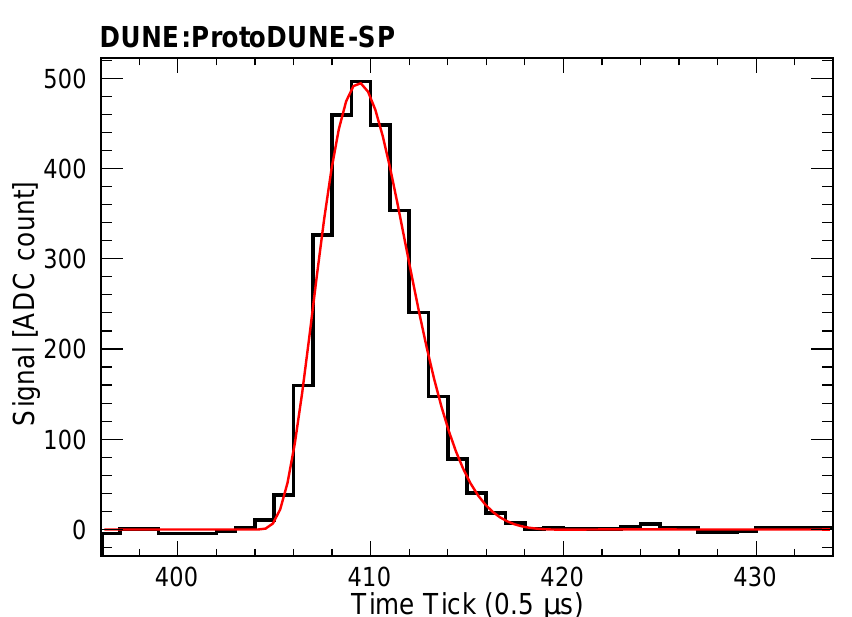
Figure 1. Response of the ProtoDUNE electronics to an input charge of DAC setting 3. The red curve is fit to a simulated function of electronics response. Plot courtesy of David Adams (Brookhaven National Laboratory) and the DUNE collaboration.